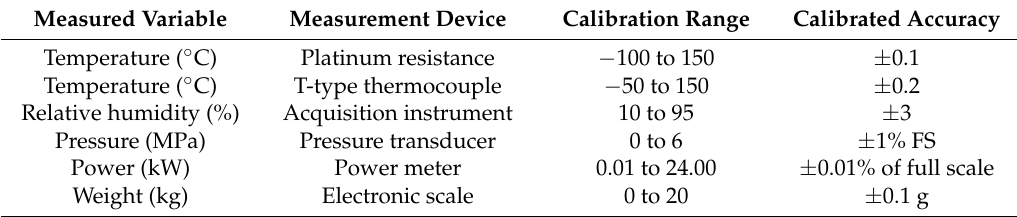
Table 12. Operation conditions for the experimental FFASHP water heater system.